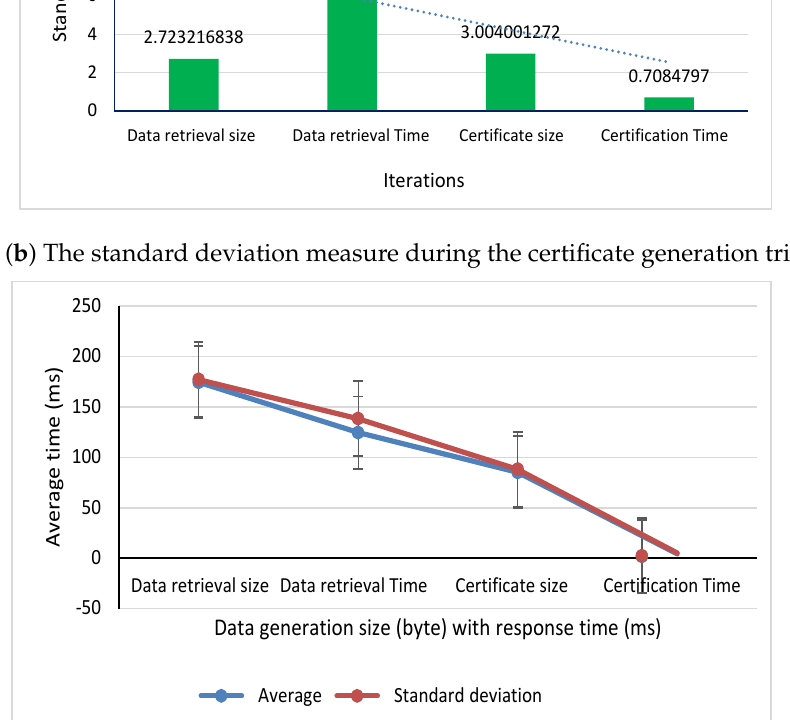
Figure 13. Performance evaluation of the proposed digital certificate